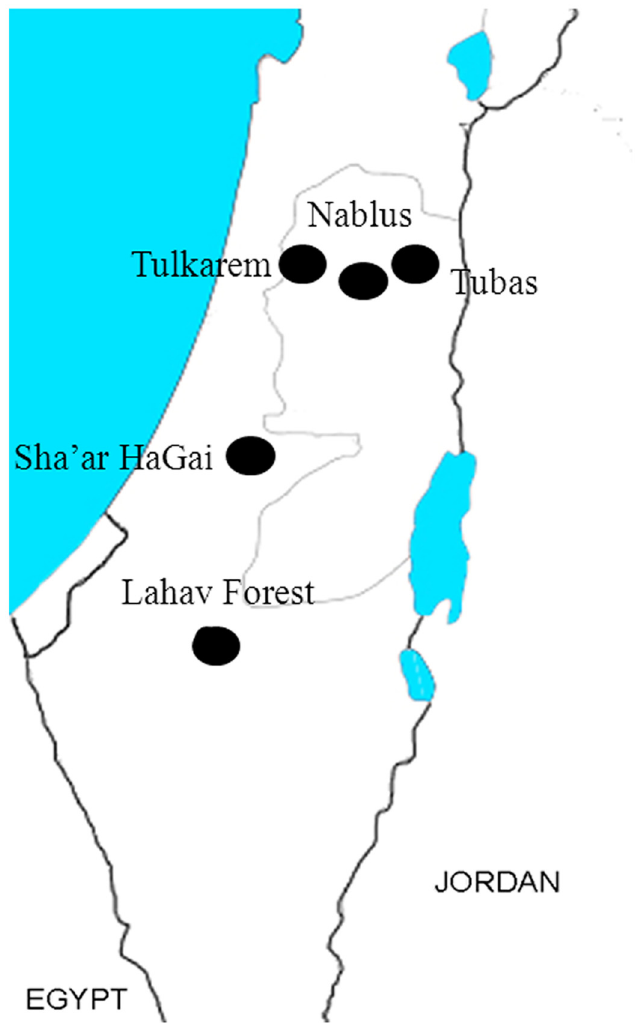
Fig 1. Sampling sites. Drawing of the Eastern Mediterranean (Israel, Palestine, Jordan and Egypt) showing the location of the five sampling